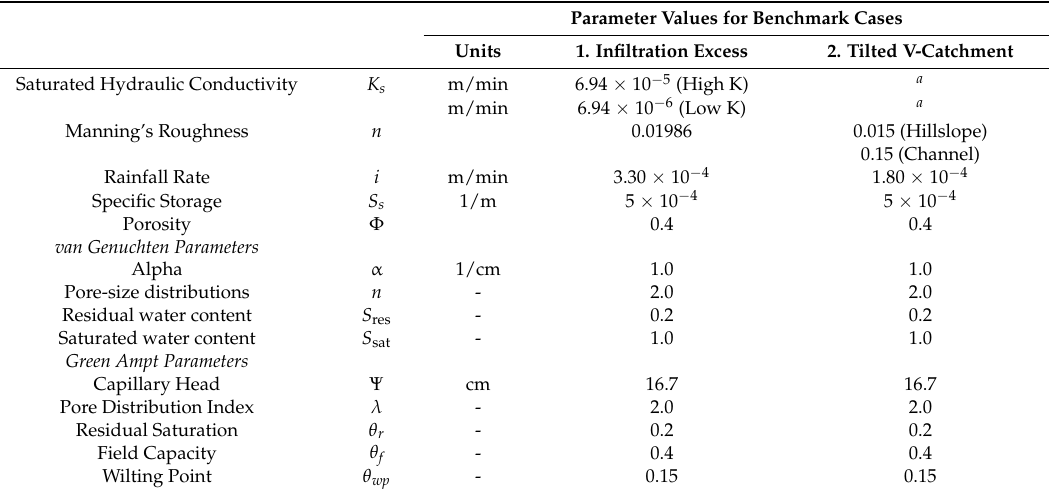
Table 2. Parameter values used in the benchmark